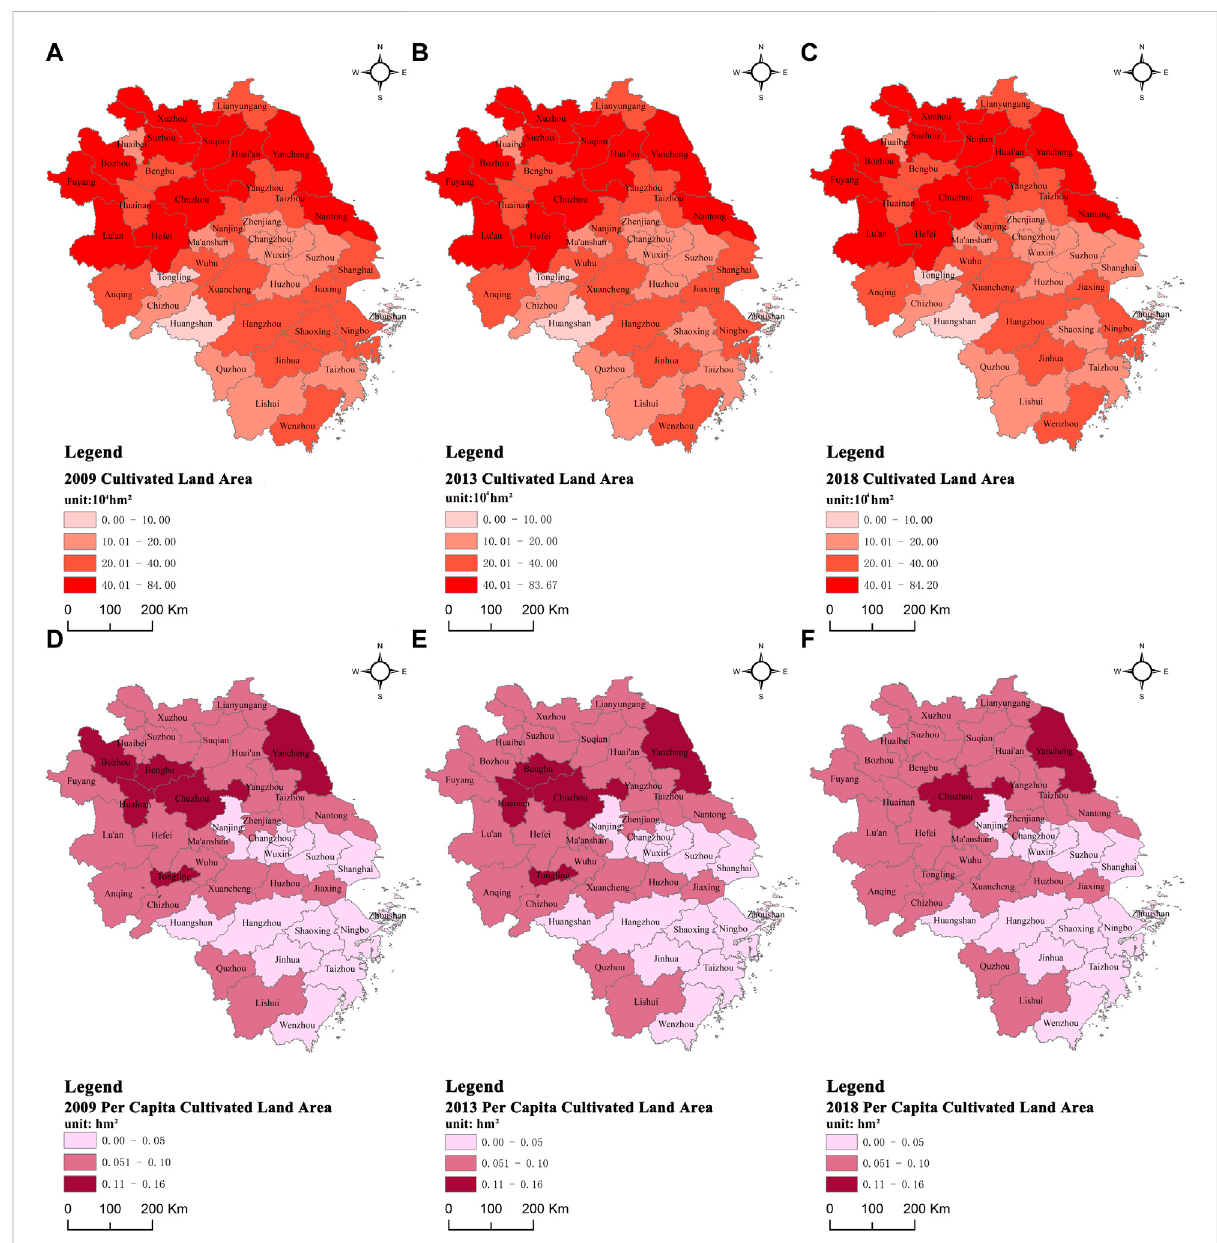
FIGURE 4 Spatial distribution of cultivated land area and per capita cultivated land area in 2009, 2013, and 2018. (A – C) represent cultivated land area in 2009, 2013, and 2018, respectively. (D – F) represent per capita cultivated land area in 2009, 2013, and 2018,